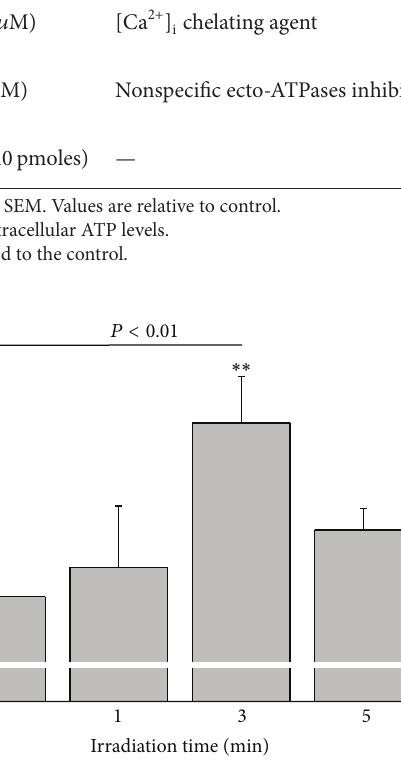
Figure 2: Changes of intracellular ATP content in HMC-1 cells in response to 657 nm and 0.28 W/cm 2 laser irradiation. Relative changesofintracellularATPcontentinHMC-1cellsinducedbylaser irradiation averaged for the respective irradiation times of all sam- ples. The data represent averages ± SEM from 𝑁 = 3 – 7 independent experiments. ∗ 𝑃 < 0.05 , compared to the preirradiation